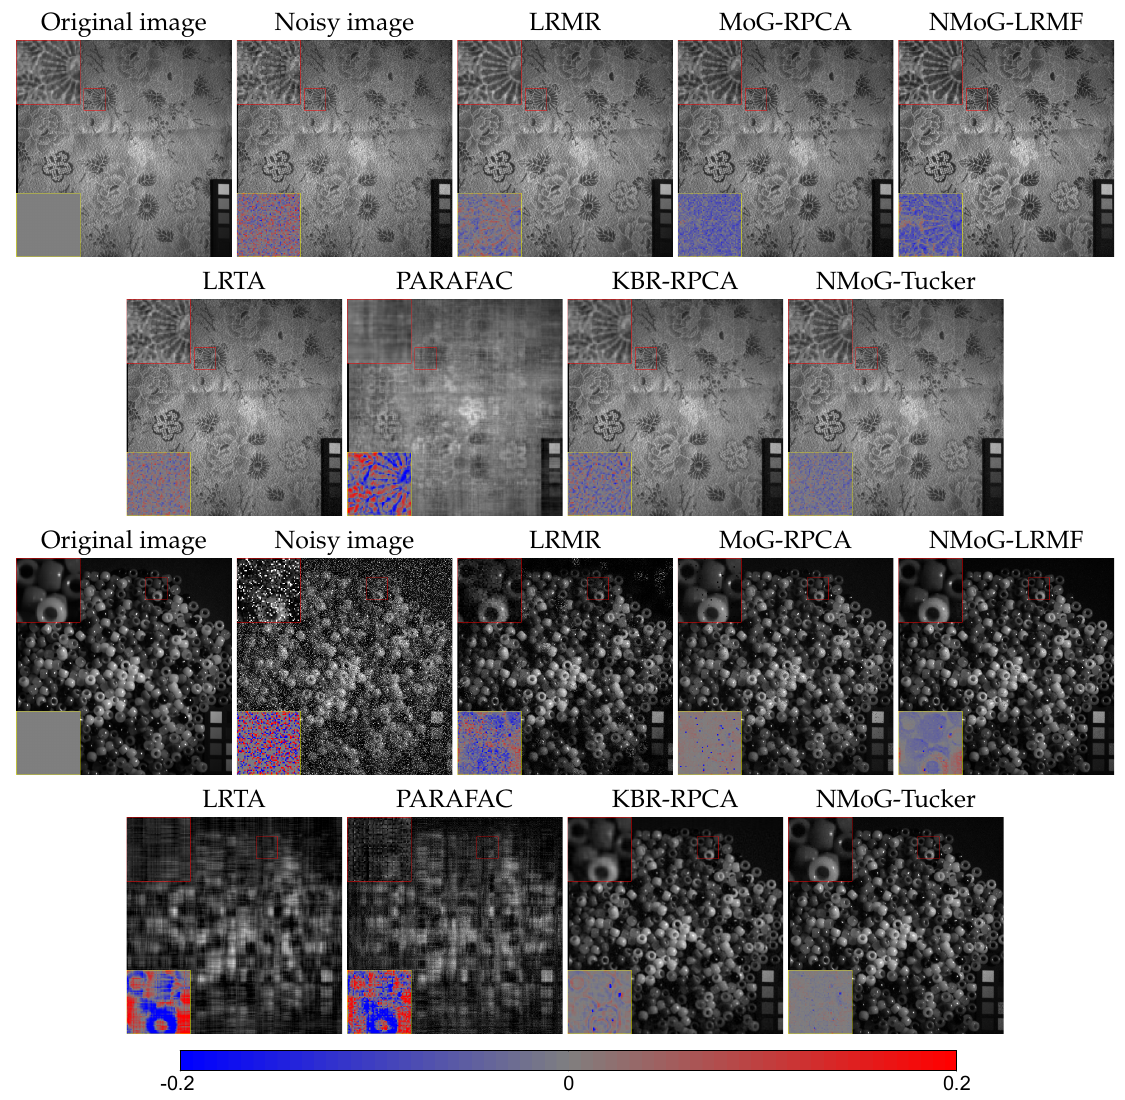
Figure 3. MSI denoising examples. Top two rows: band 31 in Cloth under Gaussian noise. Bottom two rows: band 31 in Beads under mixture noise. For better visualization, we show enlargements of two demarcated patches and the corresponding error maps (difference between the currently displayed patch and the original one). Error maps with less color information indicate better denoising